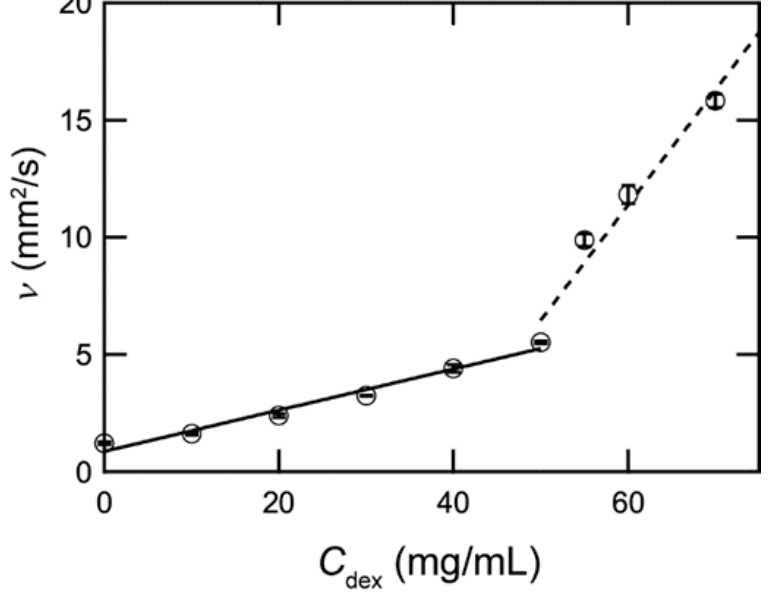
Figure 1. Relationship between C dex and ν in a water-based dextran solution. The solid and dashed lines represent the linear regression between a C dex ranging from 0–50 and 50–70 mg/mL, respectively. Error bars represent the standard error of the mean calculated from three independent